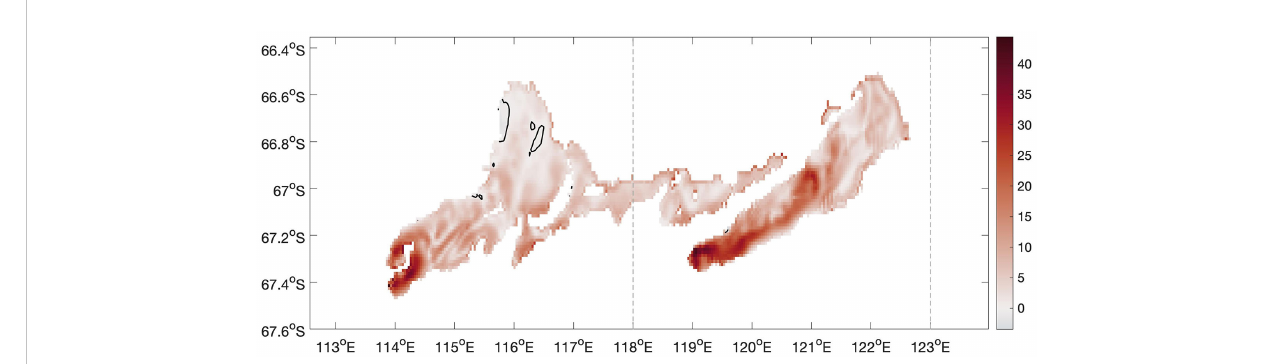
FIGURE 4 Annual mean basal melt rate (m yr -1 ) distribution for the TIS and the MUIS area in the 2014 simulation year. The area within the black contour has negative mean basal melt rate, that is basal freezing is simulated there. Two of the three longitudinal transects (Figure 1) are shown as dashed lines. Figure used cmocean (Thyng et al.,